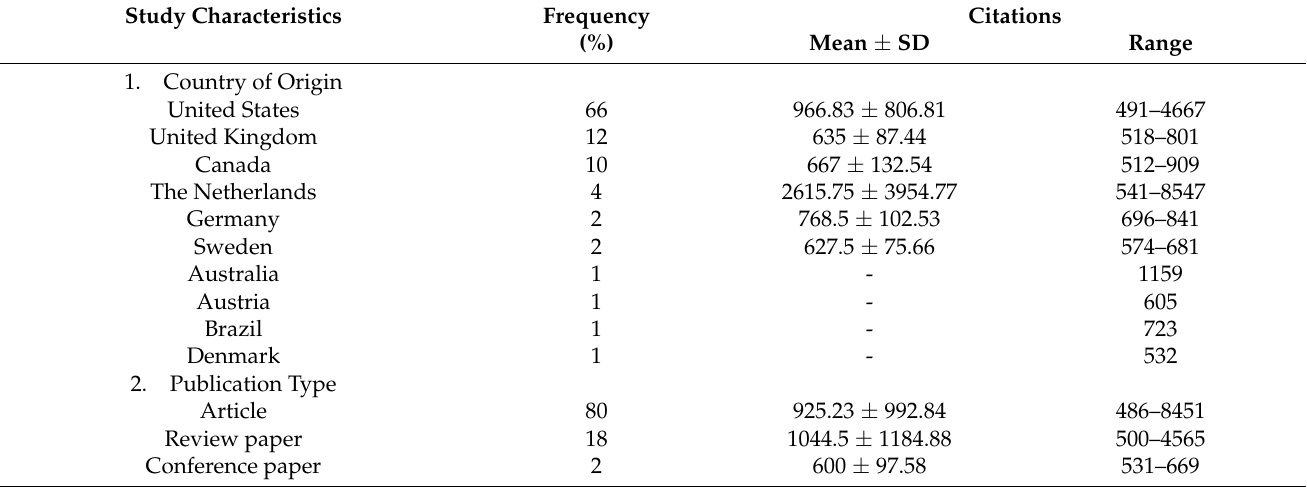
Figure 1. The PRISMA flowchart of study selection. Table 1. Study characteristics of the top 100 published